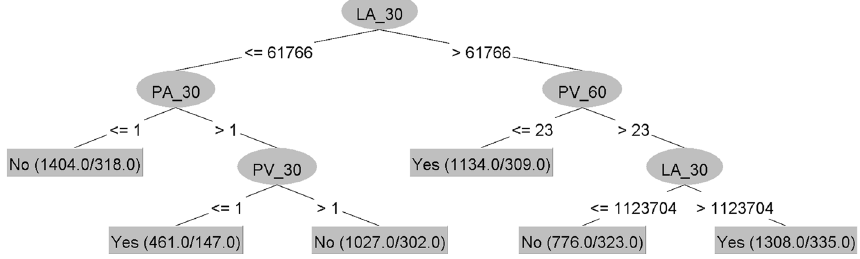
Fig. 4 Combined tree (Tree